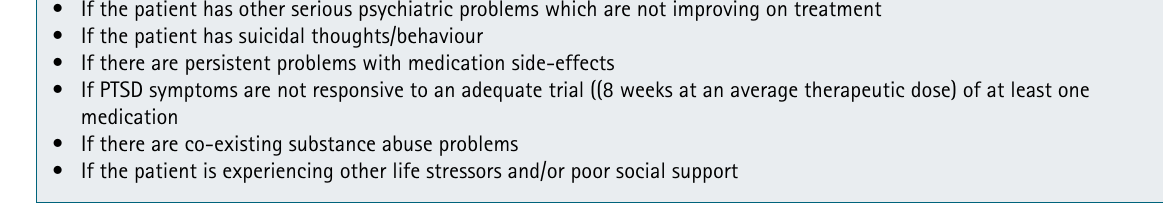
taBlE ii. WHEn tO REFER FOR spEcialisEd psYcHiatRic